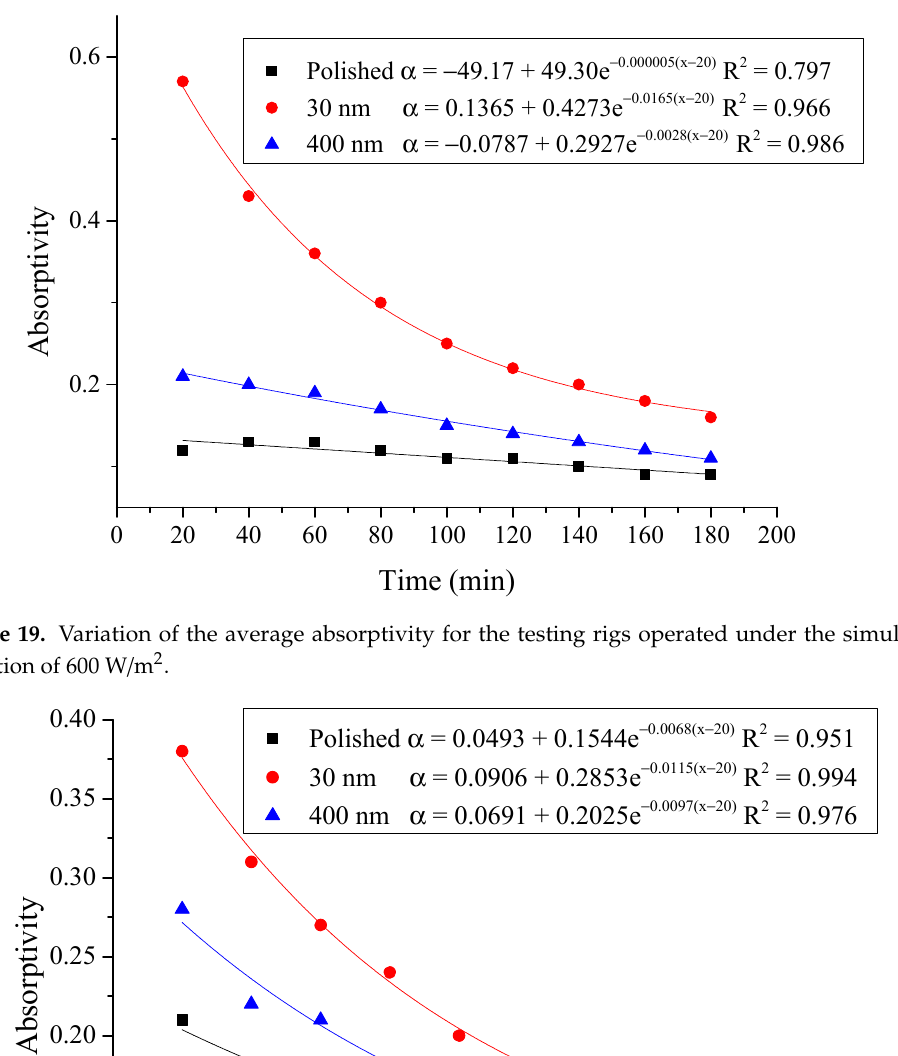
Figure 18. Variation of the average absorptivity for the testing rigs operated under the simulated radiation of 500 W/m 2 .